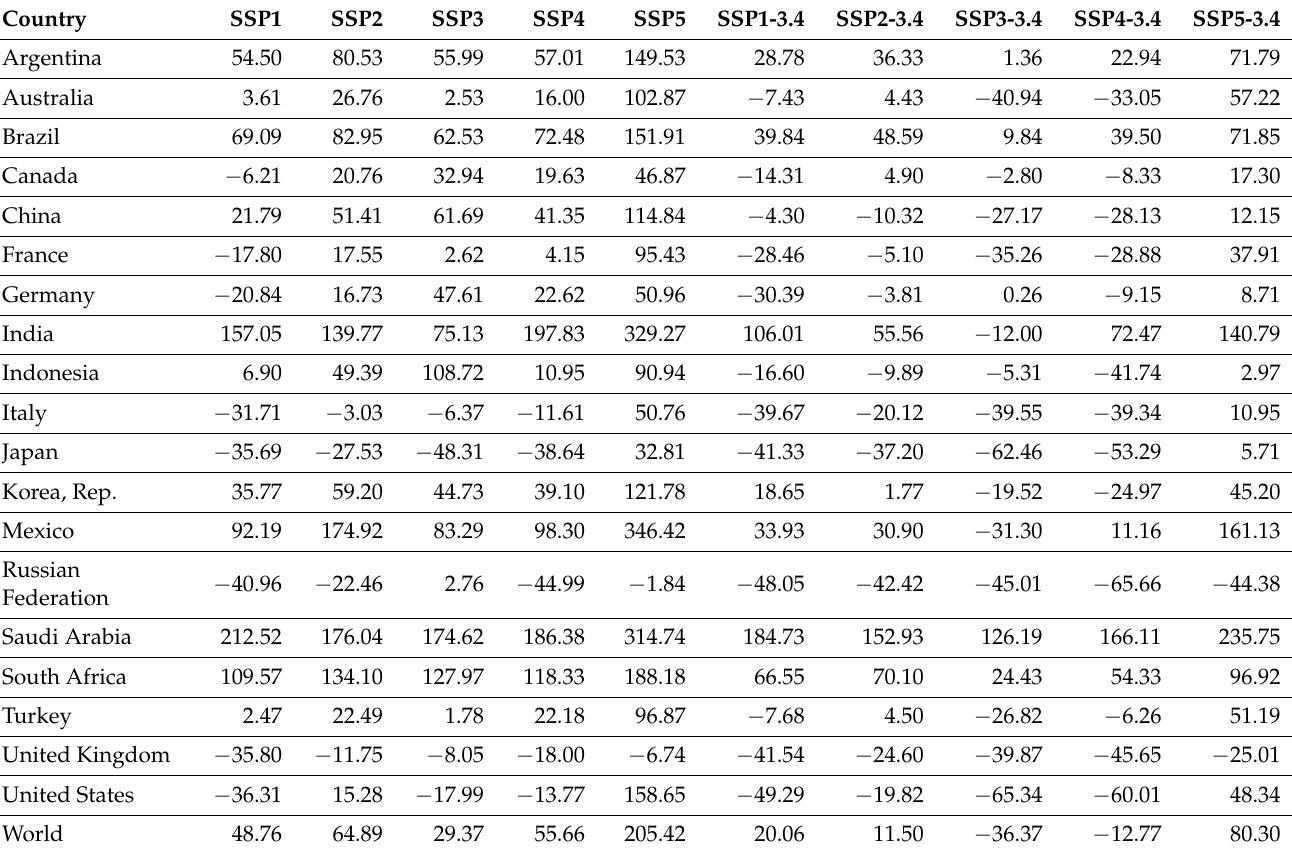
Table 4. Growth rate of CO 2 emissions in 2050 compared to